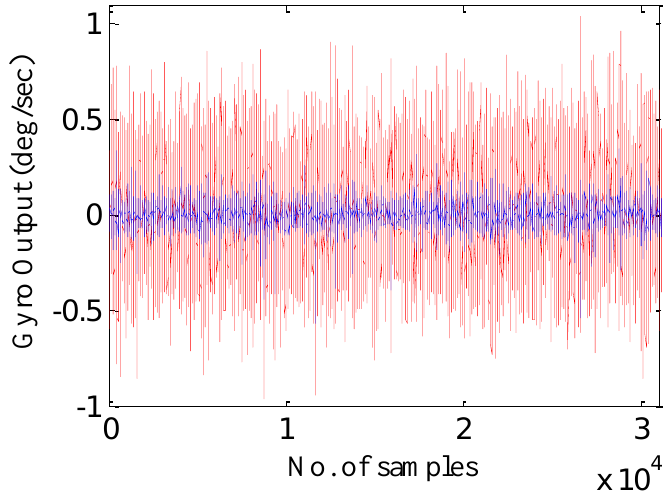
Figure 7. Gyroscope X output, red: uncompensated, blue: compensated.